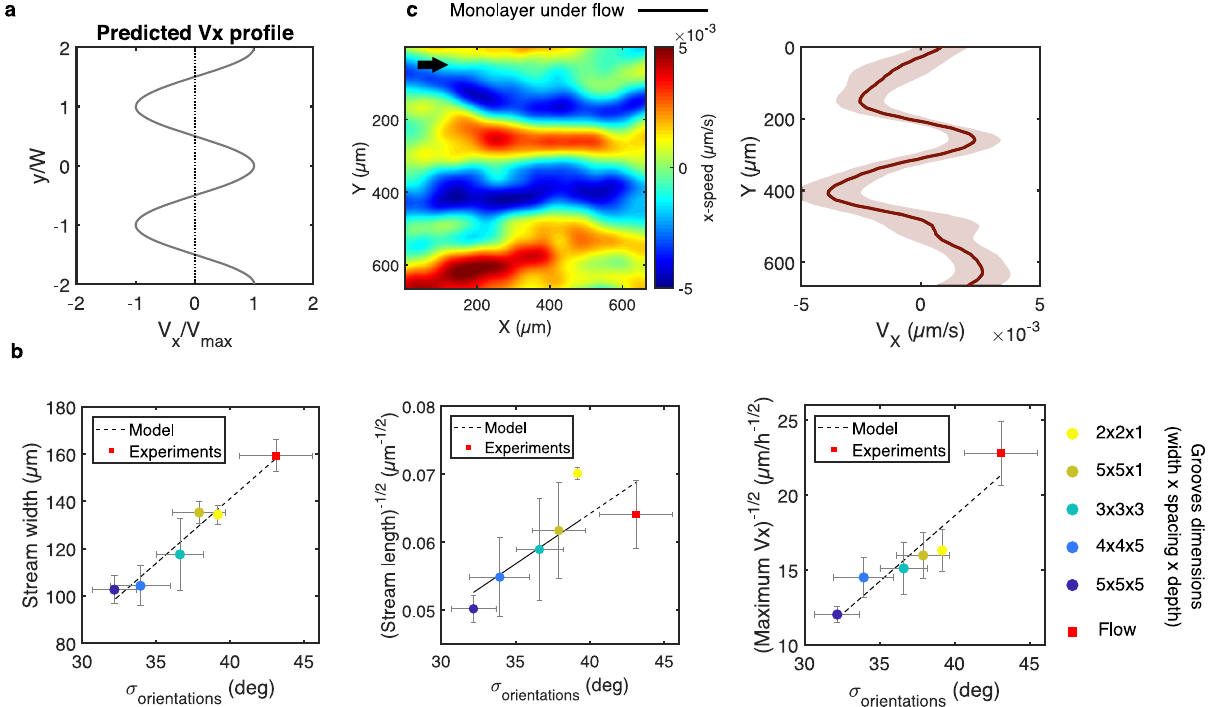
Fig. 5 Modeling the emergence of cell streams. a V x pro fi le predicted by the model. b Predicted relationship between the spatial features or speed of the streams and the standard deviation of the displacement vector orientation angles. Dots represent experimental points and dashed lines the linear fi t predicted by the model. Error bars represent SEM. c V x heatmap and corresponding V x pro fi le of HUVEC monolayer on a fl at surface subjected to a laminar shear stress of 2 Pa for 24 h. Black arrow indicates the fl ow direction. Source data are provided as a Source Data fi